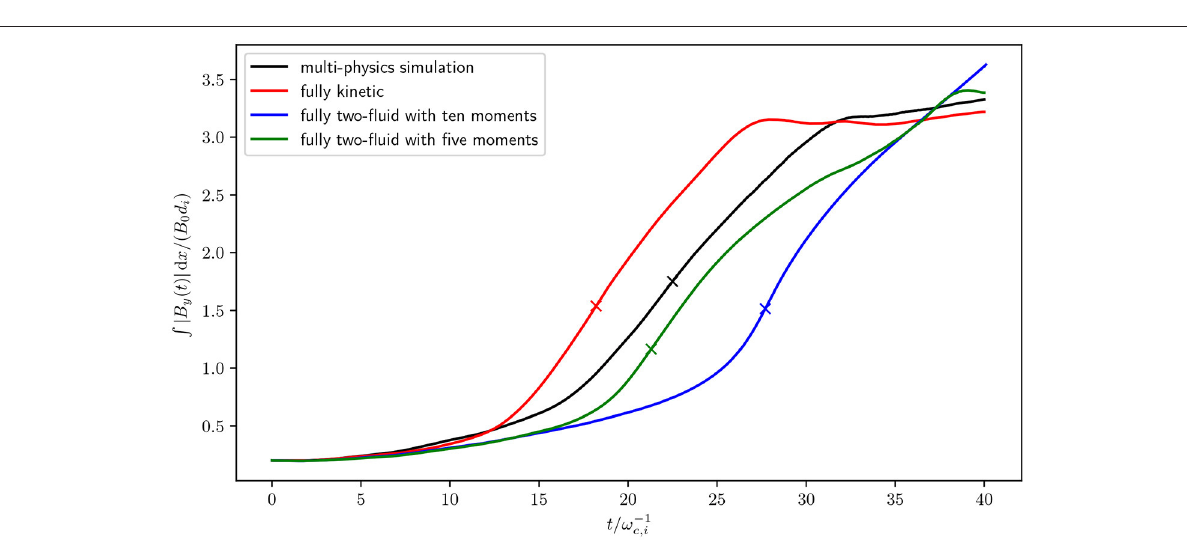
we use the reduced speed of light of 20 times the Alfvén speed. The numerical setup is depicted in Table 2